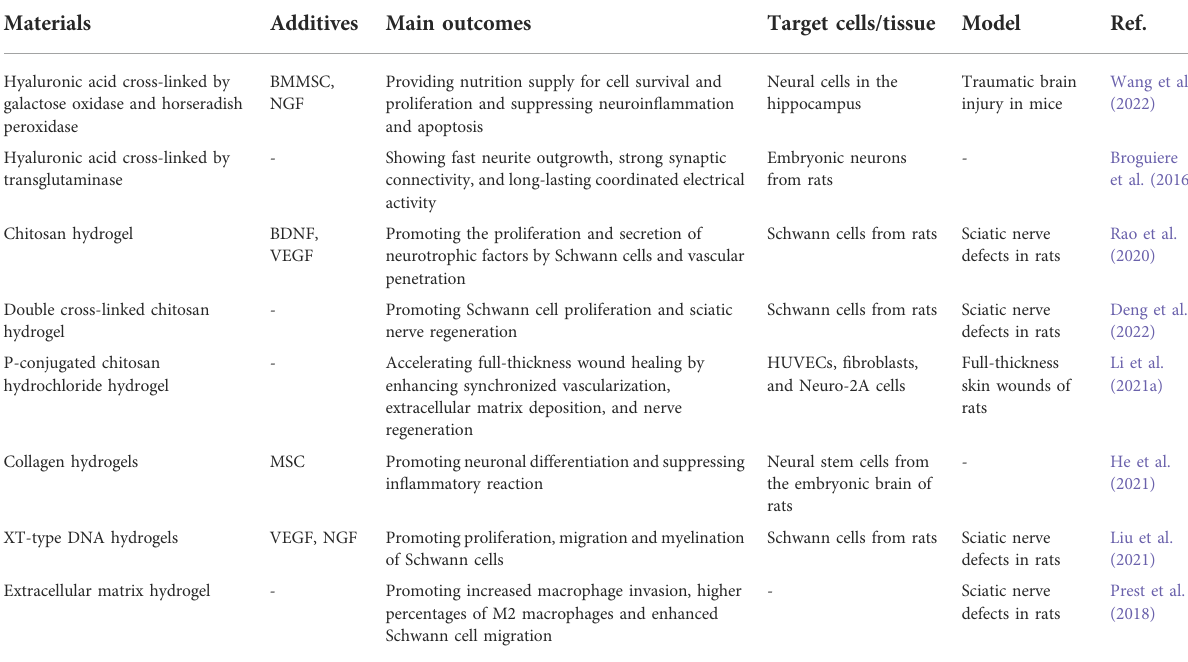
TABLE 2 The common hydrogel materials in nerve